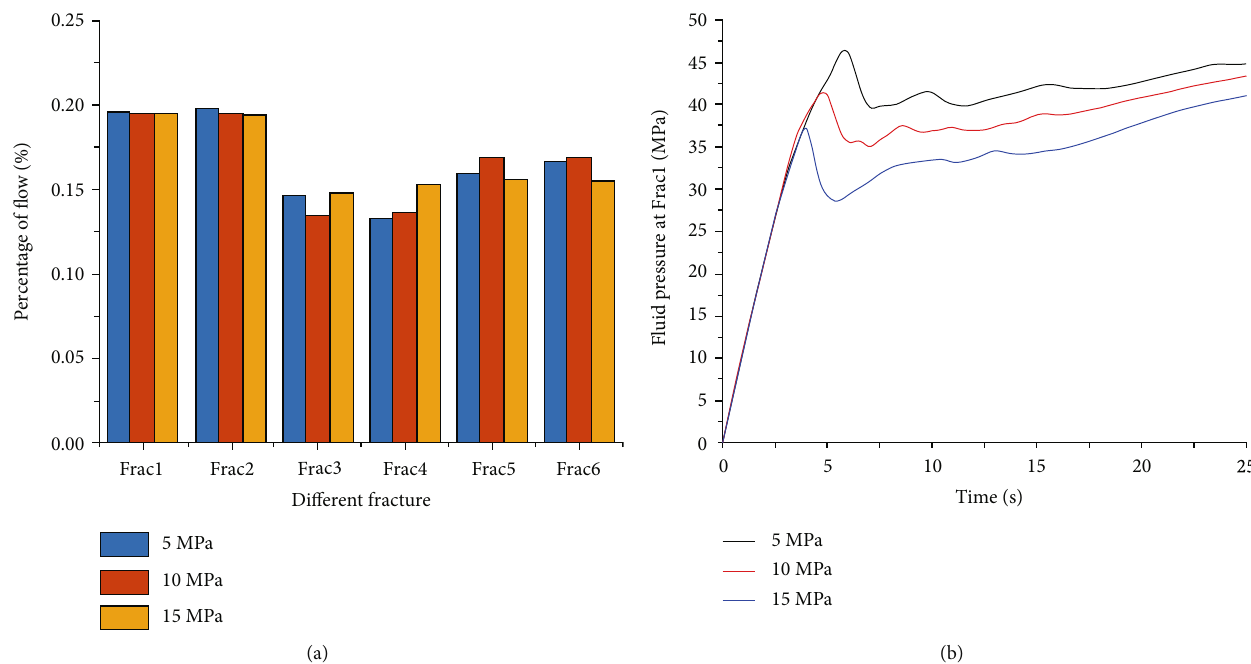
Figure 12: (a) Fluid distribution in fractures and fl uid pressure (b) for varying in situ stress di ff erences.